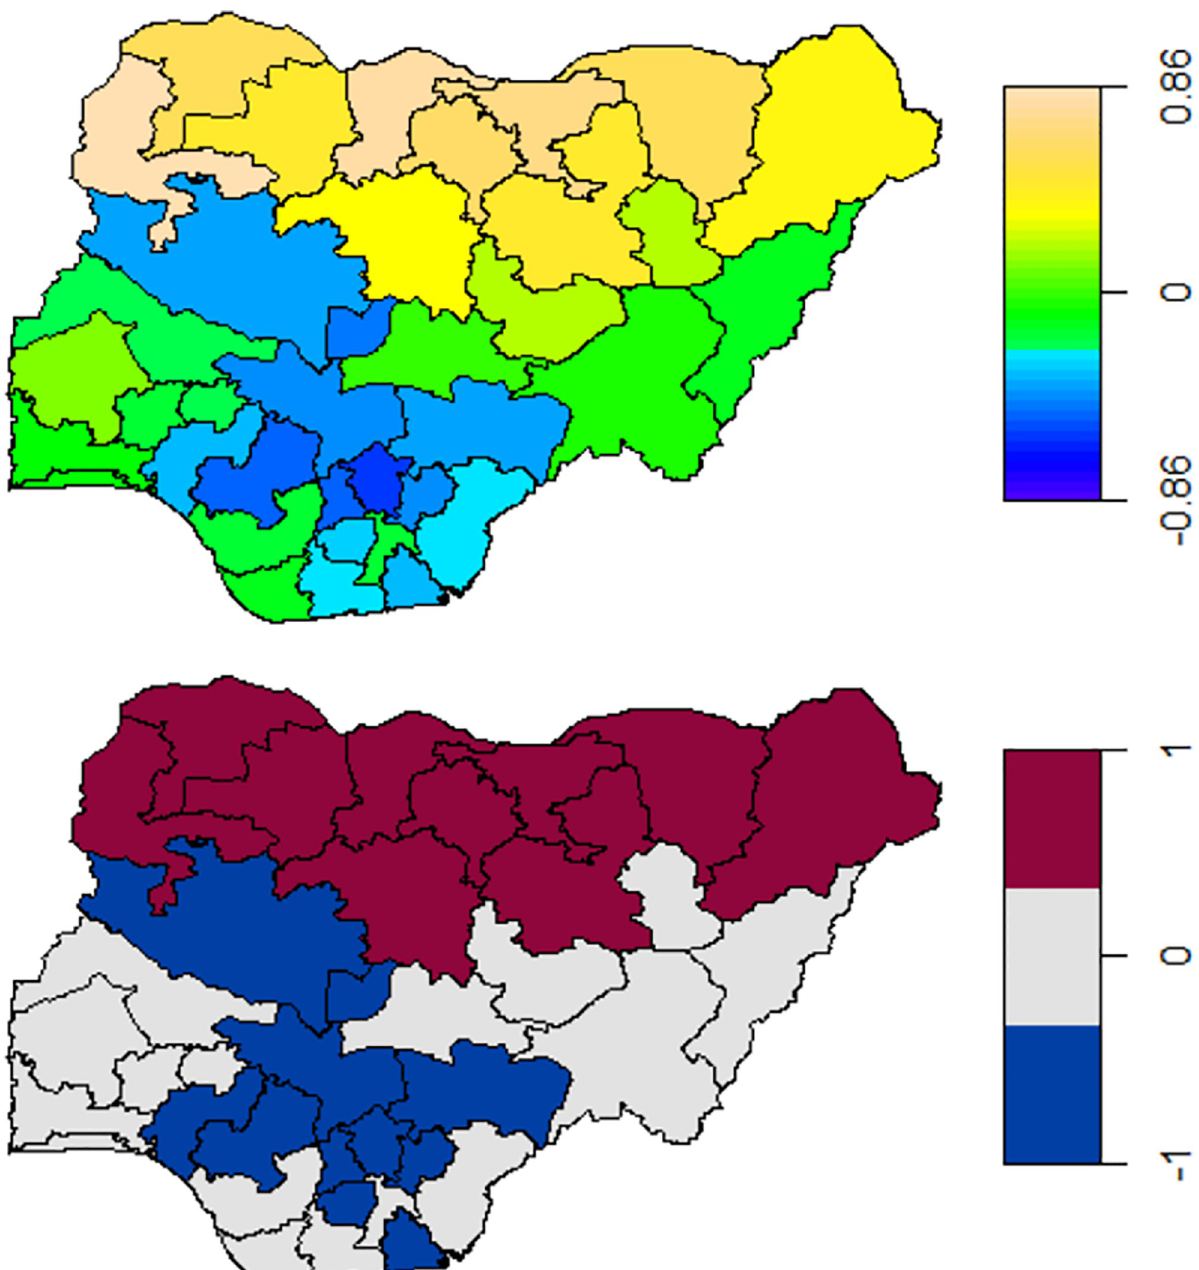
Fig 4. The estimated posterior means of structured spatial effects (Top panel) and the 95% credible interval corresponding to the estimates of the structured spatial effects (Bottom panel). NB: The scale on the map reads 1: significant positive effect, -1: significant negative effect, and 0: no